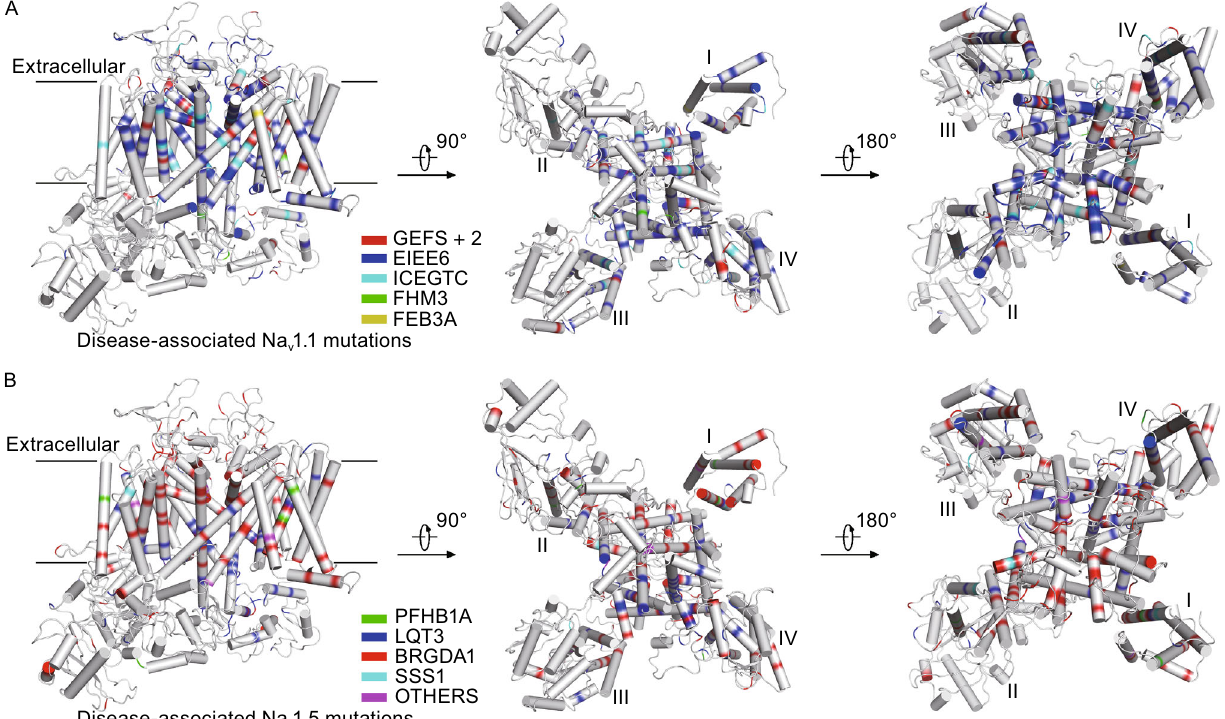
Figure 5. Distributions of the missense mutations in Na v 1.1 and Na v 1.5. (A) Distributions of Na v 1.1 missense mutations on the Na v 1.7 model structure. More than 400 mutations are mapped. Mutations from fi ve Na v 1.1-related diseases are shown from intra- membrane, intracellular, and extracellular views. The Na v 1.7 model is shown in cylindrical helices and colored by GEFS+2 in red, EIEE6 in blue, ICEGTC in cyan, FHM3 in green, and FEB3A in yellow. (B) Distributions of Na v 1.5 related-disease mutations on the Na v 1.7 structure model. Mutations from Na v 1.5 related diseases are shown from intra-membrane, intracellular, and extracellular views. Different diseases are colored in green for PFHB1A, blue for LQT3, red for BRGDA1, cyan for SSS1, and magenta for VF1, SIDS, ATRST1, CMD1E, ATFB10,